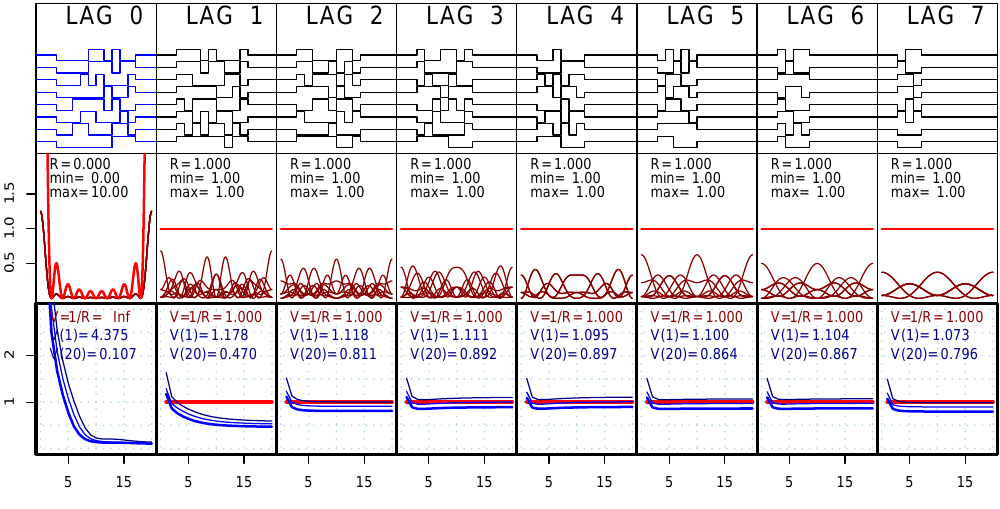
Fig. 8. Alternating code set of length 10 and type 2. In this set the problem with integration seen in the set of length 12 (previous picture) is not seen.